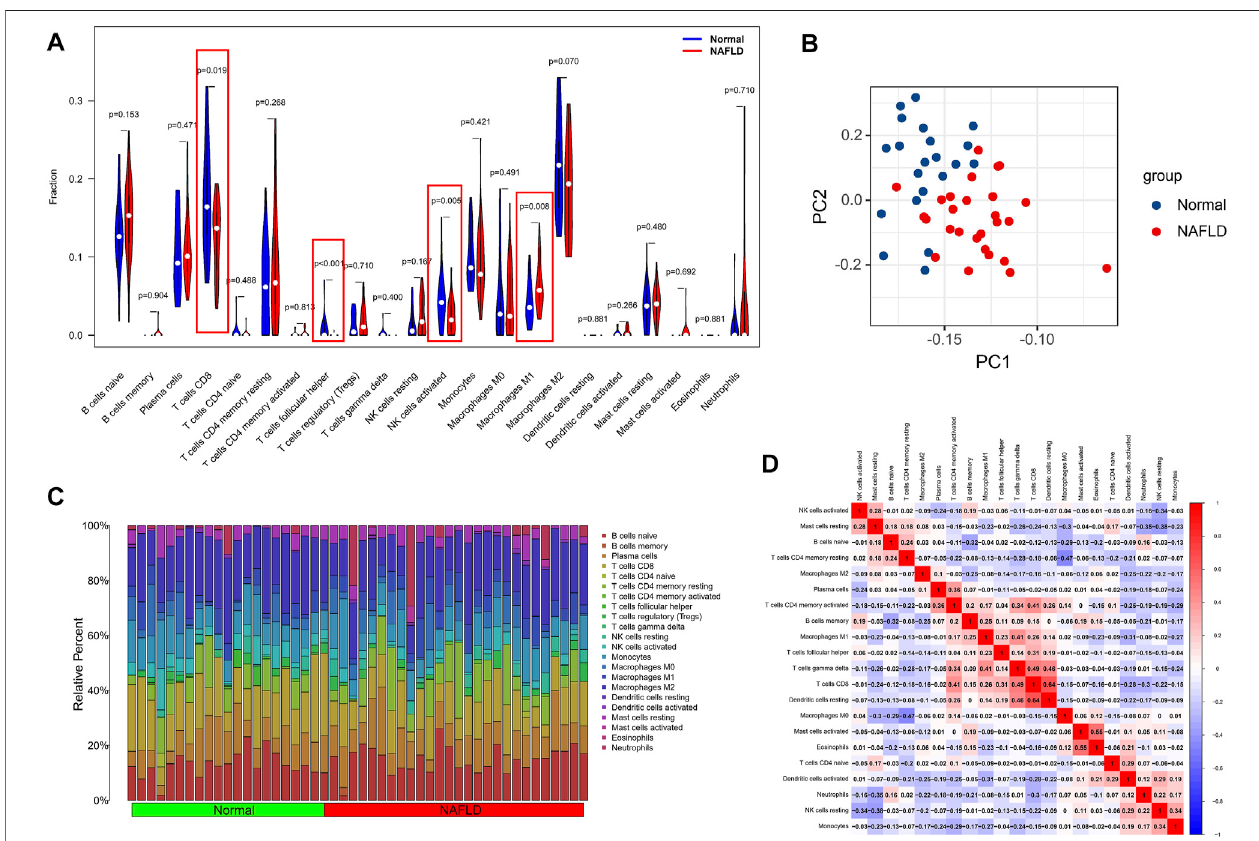
FIGURE 6 | Analysis of differences in the immune microenvironment. (A) The CIBERSORT algorithm was used to analyze the content of immune cells in different tissues, and the red markers are the immune cells with different content in the two different samples. (B) PCA analysis of the distribution of different immune cells in NAFLDand normaltissue samples. (C) Aholisticviewofthedistribution ofimmunecellsbetweendifferenttissues. (D) Correlation analysiswasperformedonallimmune cells in the CIBERSORT algorithm.